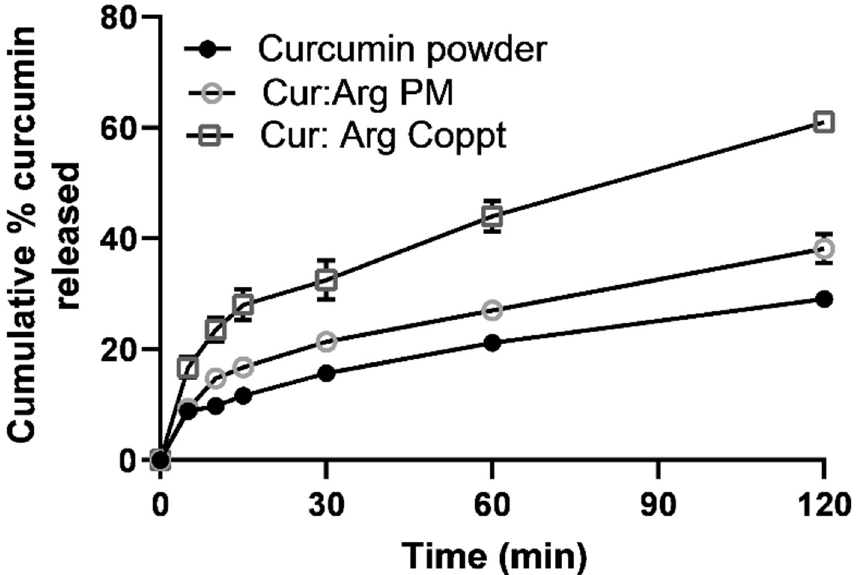
Figure 6. In vitro drug dissolution from curcumin alone, curcumin and L-arginine, and curcumin and L-arginine PM and Coppt (results are expressed as mean ± SD; n =